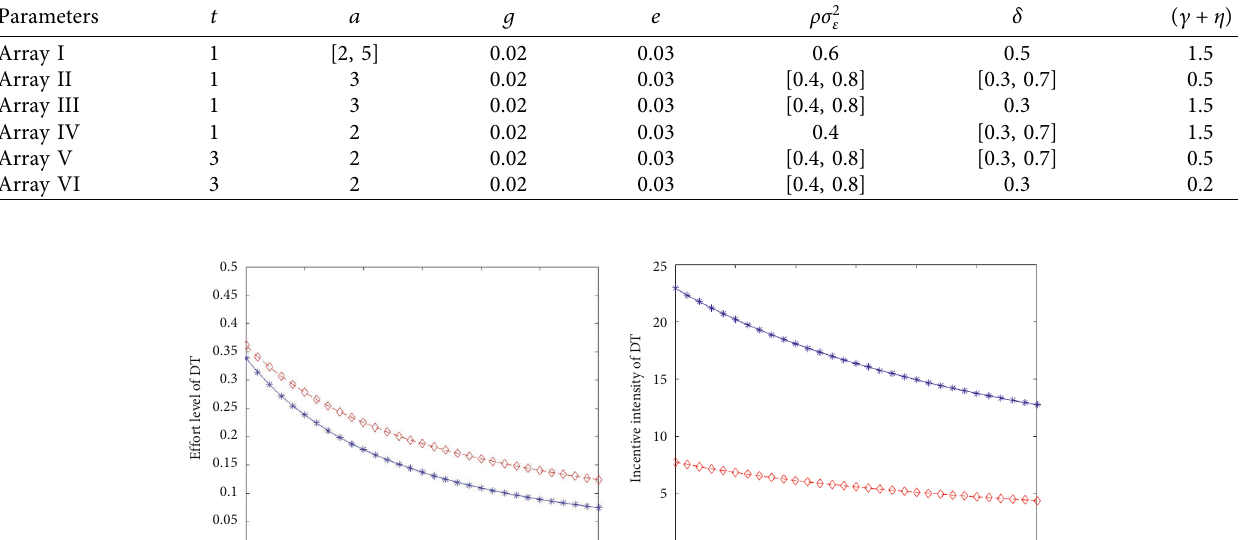
Table 1: Parameter assignments under different constraints.